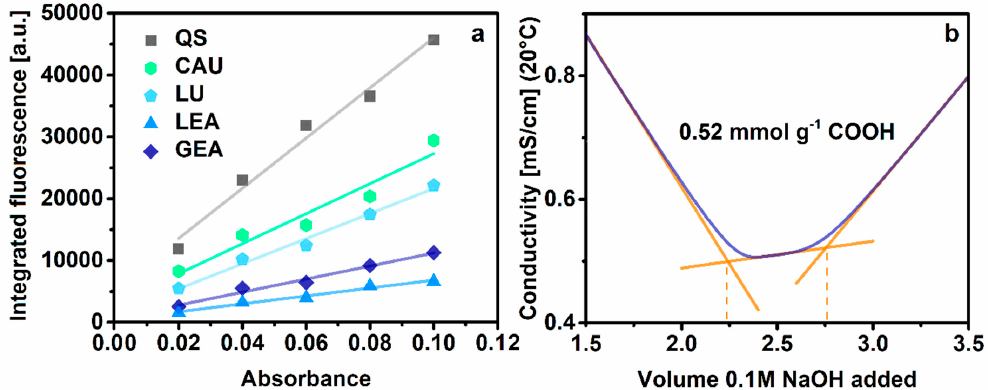
Figure 4. Relative quantum yields of the different types of carbon dots in comparison with the reference quinine sulfate (QS; a ) and conductometric titration curve to determine the degree of oxidation for bacterial cellulose (BC) subjected to TEMPO-mediated oxidation at near pH neutral conditions ( b ).